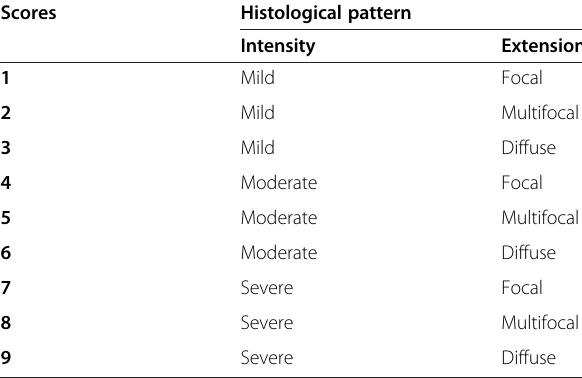
Table 1 Bladder scores according to the lesion histological